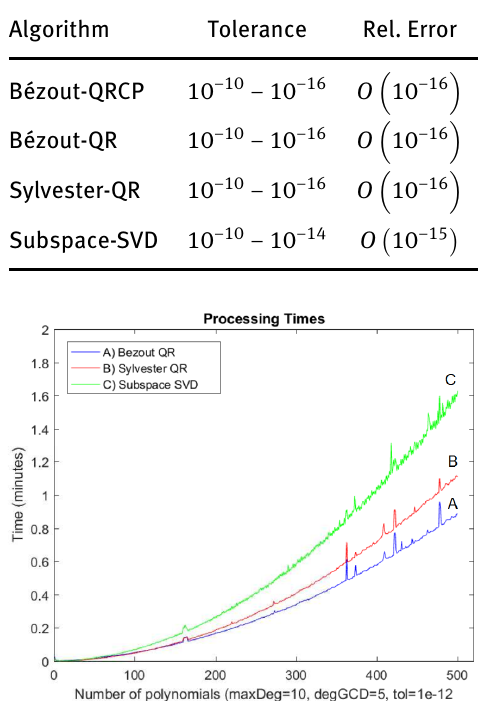
Figure 1: Computational performance